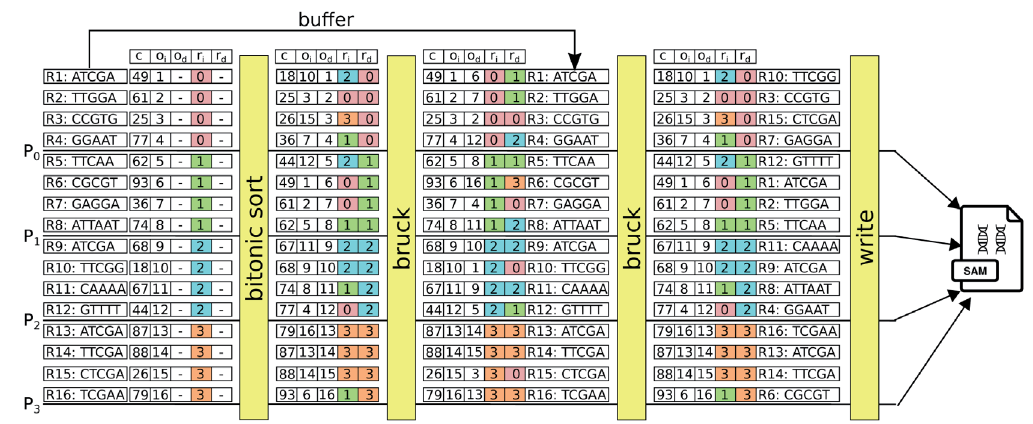
Figure 5. All-to-all communications with the Bruck algorithms for the sorting of 16 reads on four processors. The SAM file is read and split over the 4 processors P to P that sort the data with the bitonic sort. Then, a first Bruck 0 3 phase sent the r and o values back to processor from where the data originated. The data from the SAM file are sent d d by a second Bruck phase to the processor that has been assigned to write the contiguous blocks (during this step, the original data is copied into the memory buffer and then exchanged). Finally, the data can be written on a parallel filesystem. c : genomic coordinate. r : rank of the processor that parsed the block of the input SAM file. o i line from the input SAM file. r : rank of the processor that will write the block of the sorted data in the destination SAM d file. o : offset of the line in the sorted destination SAM file. d